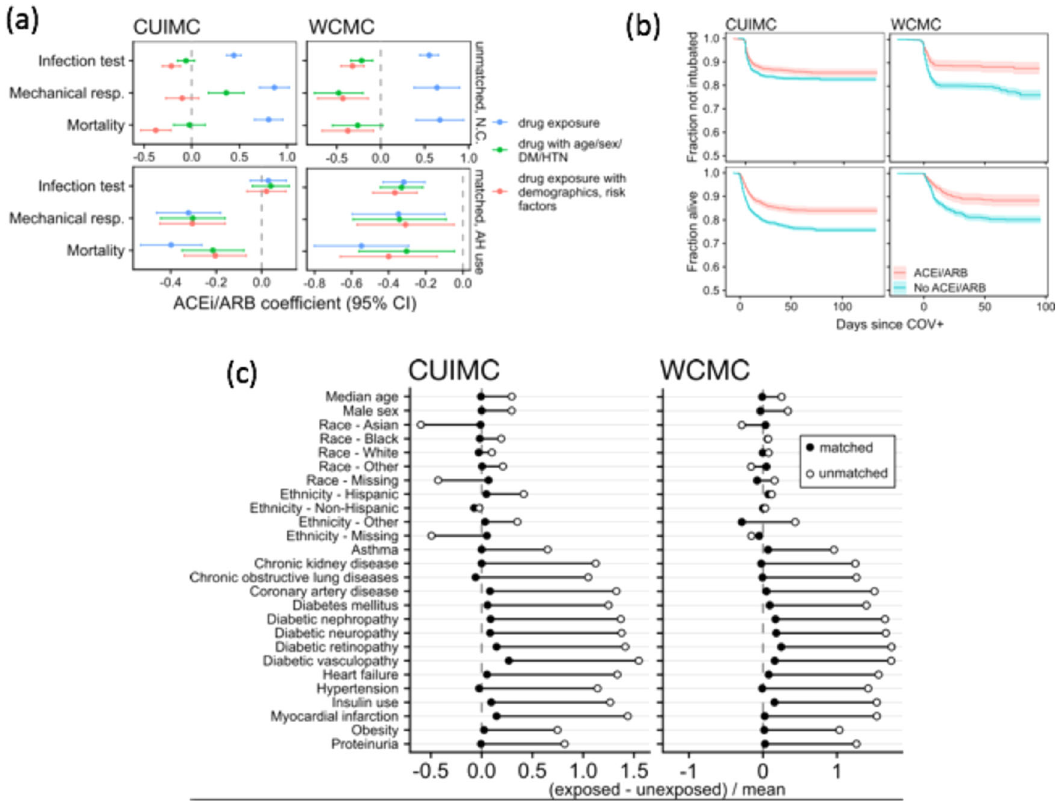
Fig. 5 Host risk to SARS-CoV-2. a Estimates for ACEI/ARB use effect on SARS-CoV-2 infection test result, intubation, and death. Upper panels show estimates from all patients without propensity matching (unmatched, no condition (N.C.)). Lower panels show estimates from propensity-matched patients with recent exposure to antihypertensive (AH) drugs (ACEI, ARB, BB, CCB, and THZ) (Supplementary Data 6). Center points show the estimated coef fi cient and the error bars show 95% con fi dence interval. Coef fi cients represent effect size estimates from logistic regression (for infection test outcome) or Cox proportional hazards regression (mechanical respiration and mortality), and can be interpreted as log odds ratios (former outcome) or log hazard ratios (latter outcomes). Colors indicate the variables used for regression on the cohort (drug exposure alone (blue), drug exposure plus age, sex, history of diabetes mellitus (DM), history of hypertension (HTN) (green), drug exposure plus all demographics and risk factors considered (red)). Left panels show estimates from NYP-CUIMC data, right panels show estimates from NYP-WCMC. b Curves for 50,821 patients requiring mechanical respiration (top panels) and survival (bottom panels), as a function of time since con fi rmed infection and recent ACEI/ARB exposure status. Cohorts created using propensity matching. Left panels give data from NYP-CUIMC, right panels give data from NYP-WCMC. c Comparison of cohorts before and after propensity matching. Each point represents a difference in the mean between exposed and unexposed cohorts, divided by the mean of exposed and unexposed cohorts. Filled circles give these standardized differences after propensity matching, un fi lled circles give values before